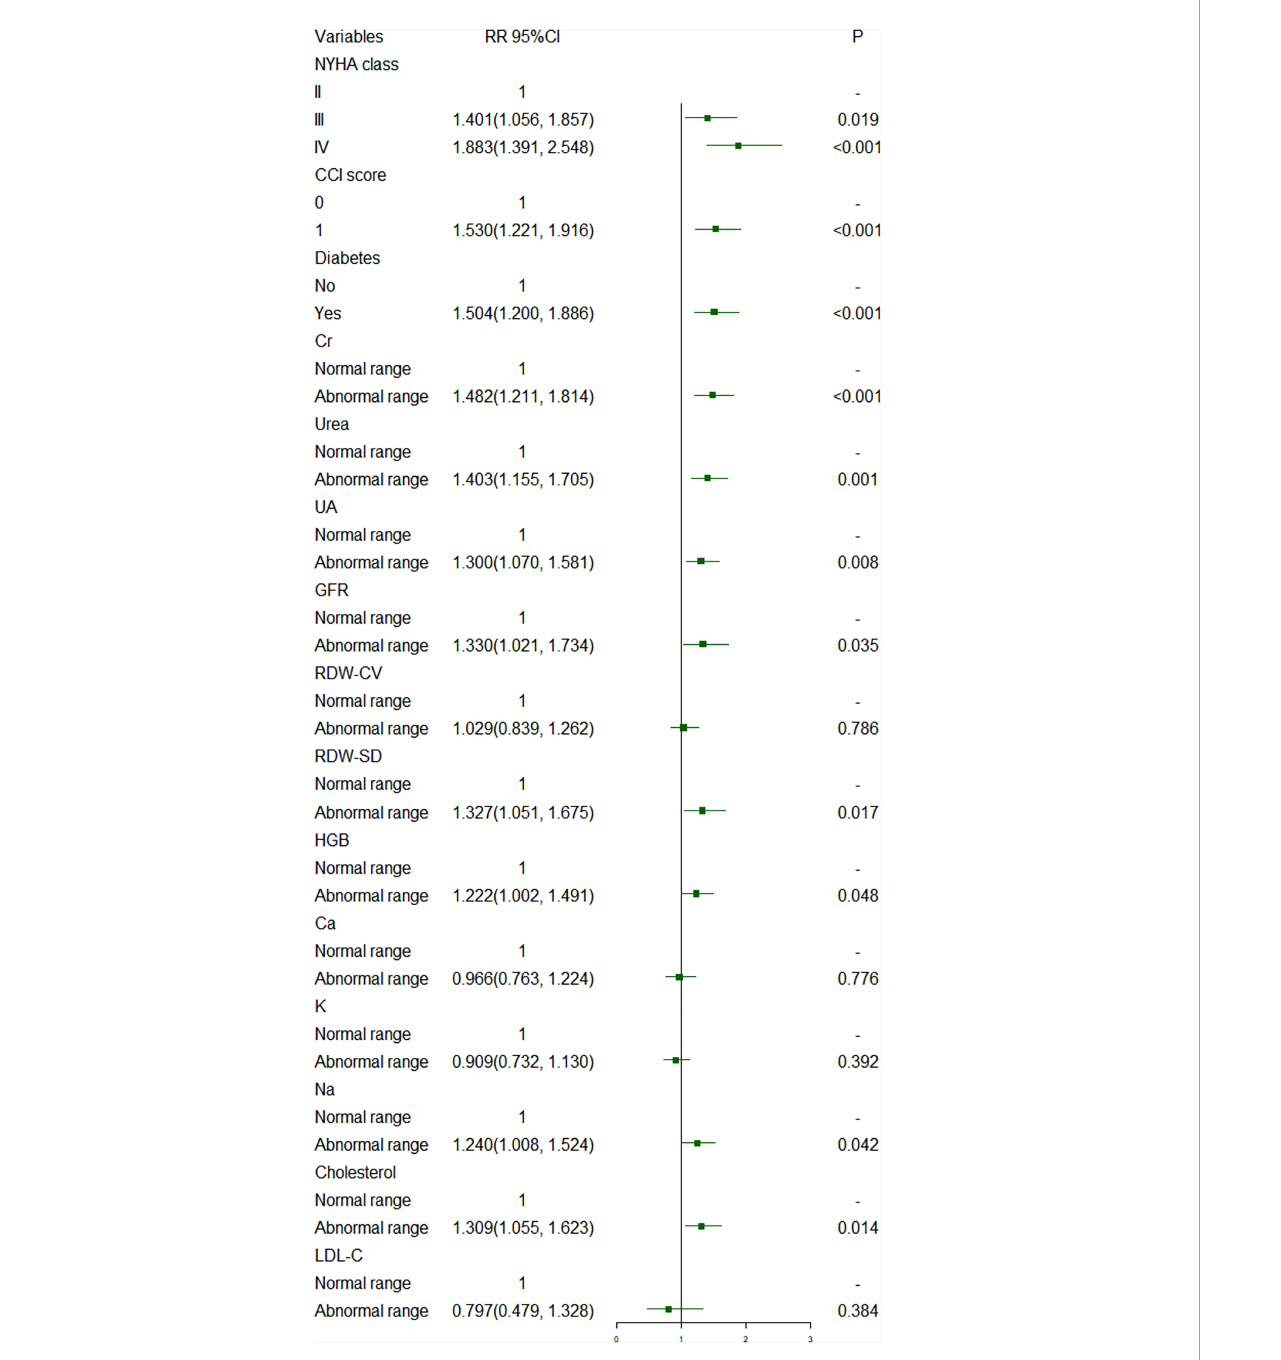
FIGURE 1 Risk factors for readmission within 6 months of heart failure patients: univariate logistic regression (Normal range: Cr: 44-110µmol/L; Urea: 1.7- 8.3 mmol/L; UA: 150-440 µmol/L; GFR: 90-120 mL/min/1.73 m ^2 ; RDw-CV: 0-15%; RDW-SD: 40-53 fL; HGB: 110-160g/L; Ca; 2.11-2.52 mmol/ L; K: 3.5-5.3 mmol/L; Na: 137-147 mmol/L; Cholesterol: 2.90-5.68 mmol/L; LDL-C: 0-3.36